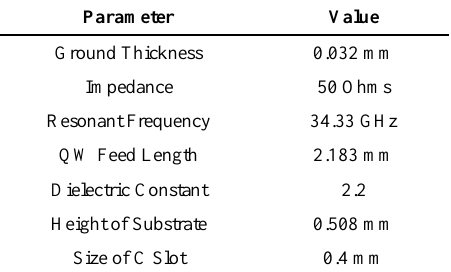
Figure 5. Proposed Patch Antenna with C Slot Table 1. Design Specifications of Proposed